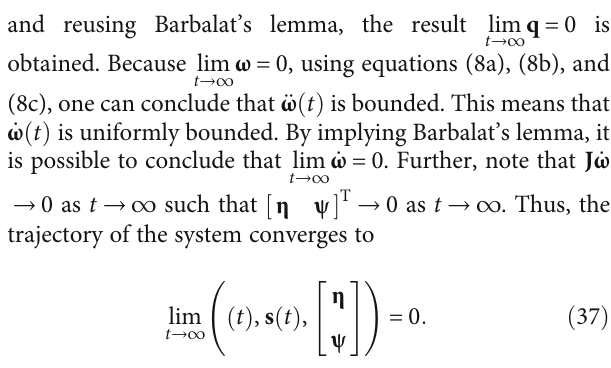
Figure 4: Time histories of liquid sloshing displacement in Case